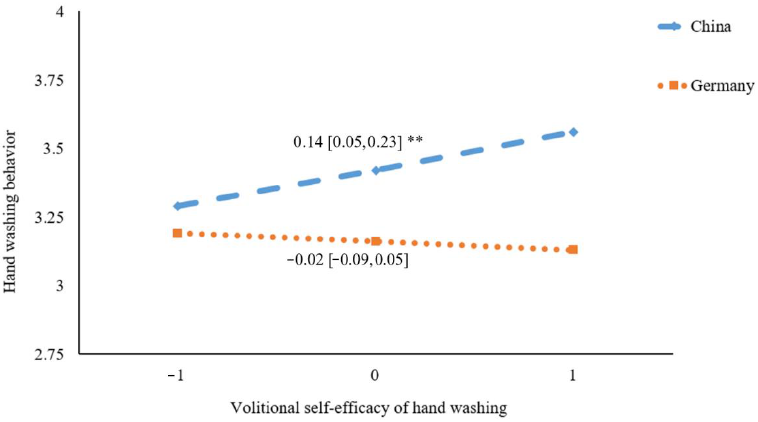
Figure 1. Plot of simple slopes showing the association between volitional self-efficacy and hand washing at different countries ( n = 560); ** p < 0.01.